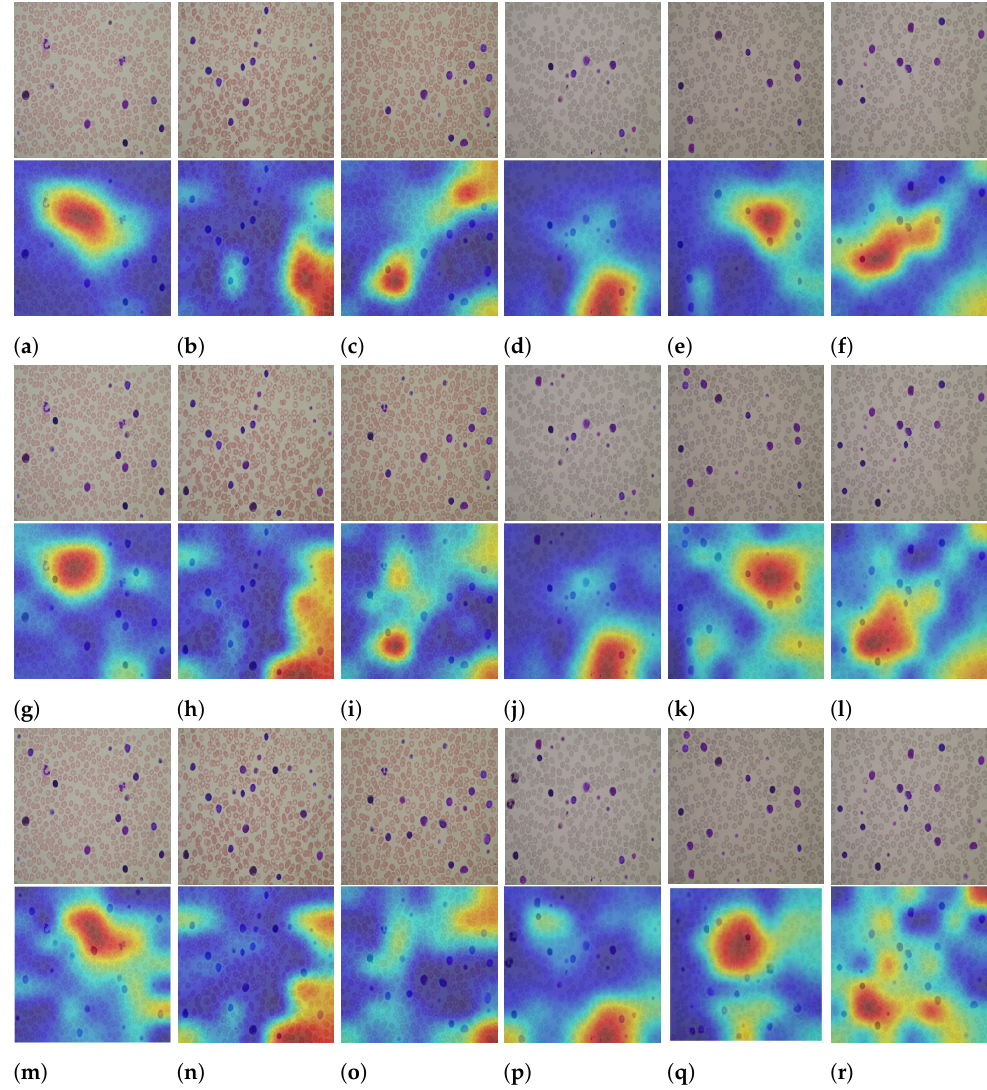
Figure 8. Visual Grad-CAM explanations for ResNet-50 exploited on different synthetic test sets. From top to bottom, examples of images belonging to imgSynt10 , imgSynt15 , and imgSynt20 . Im stands for image, and S stands for set. ( a ) Im: 34, S: 10 ( b ) Im: 43, S: 10 ( c ) Im: 47, S: 10 ( d ) Im: 71, S: 10 ( e ) Im: 72, S: 10 ( f ) Im: 74, S: 10 ( g ) Im: 34, S: 15 ( h ) Im: 43, S: 15 ( i ) Im: 47, S: 15 ( j ) Im: 71, S: 15 ( k ) Im: 72, S: 15 ( l ) Im: 74, S: 15 ( m ) Im: 34, S: 20 ( n ) Im: 43, S: 20 ( o ) Im: 47, S: 20 ( p ) Im: 71, S: 20 ( q ) Im: 72, S: 20 ( r ) Im: 74, S: